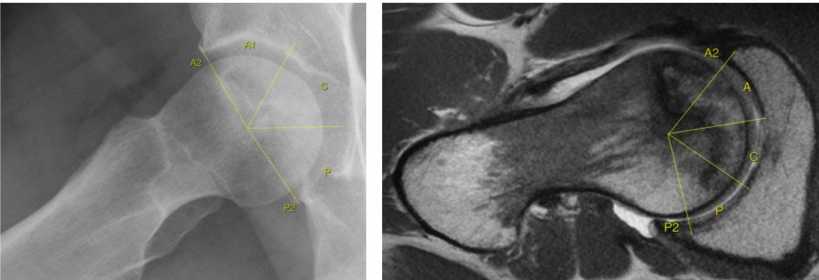
Figure 3. Location of the osteonecrosis through the anterior, central, posterior (ACP) method (from/to: anterior, central, posterior) comparing two images of case 101 in which (left) the lateral radiograph was classified as ACP and (right) the axial T1-MRI plane was classified as A2CP. The value of anterior 2 or posterior 2 means that the lesion surpasses the acetabular anterior edge (A2) or the posterior acetabular edge (P2).